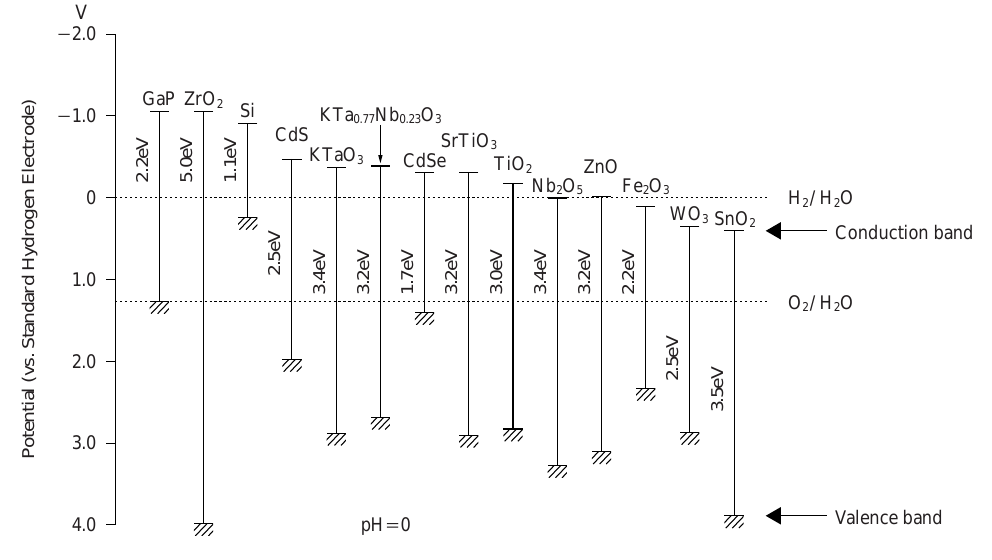
Fig. 1 Energy structures of various photosemiconductors 1)